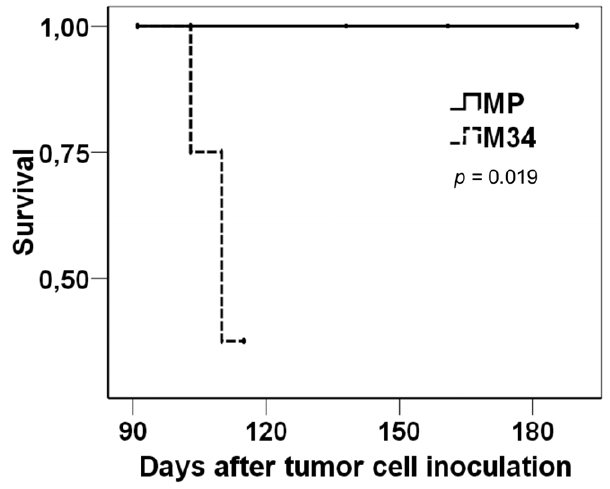
Figure 6. Kaplan-Meier plots of estimated survival after injection of MP (MDAPanc-28 mock cells) and M34 (MDA- Panc-28 ST3Gal III transfected cells). Cells (7 6 10 6 ) were intra- splenically injected in nude mice on day 1 of the experiment. Mice were daily examined and sacrificed when they looked sick. The differences between groups were assessed by the long-rank test ( P =0.019; n=7–8/ group).